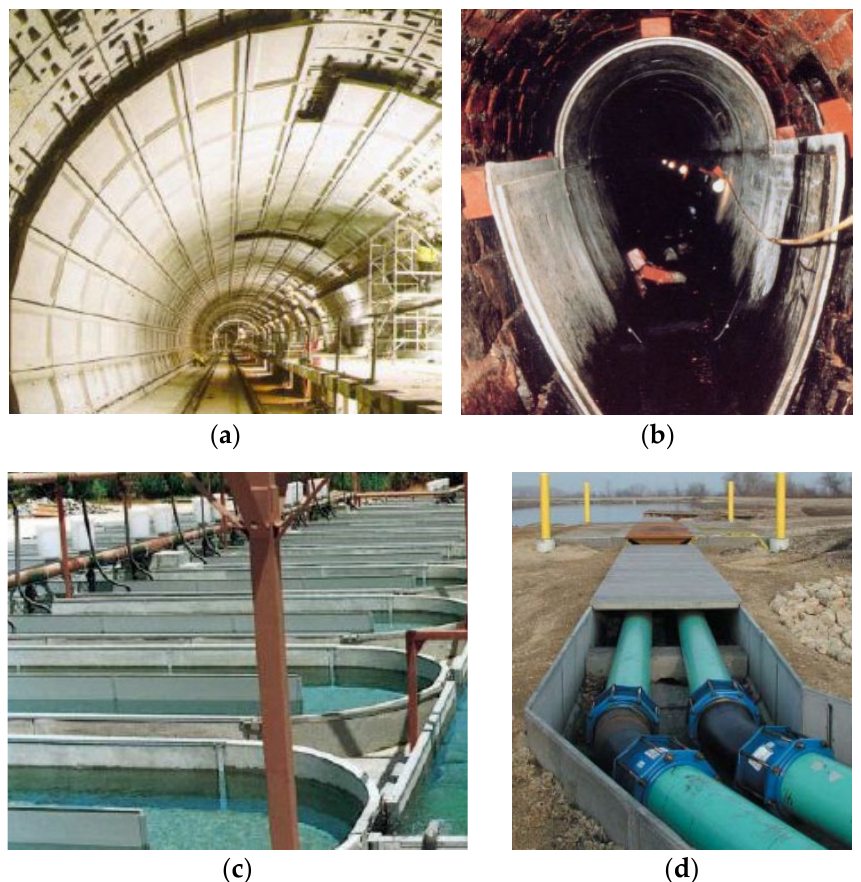
Figure 32. ( a ) GFRC tunnel panels [131]; ( b ) GFRC municipal sewerage panels [132]; ( c ) GFRC melioration system [133]; ( d ) GFRC ducts [134].